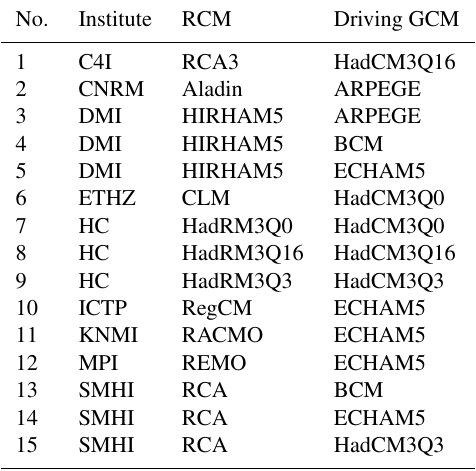
Table 1. List of RCMs from the EU ENSEMBLES project used in this study and their respective driving GCMs.